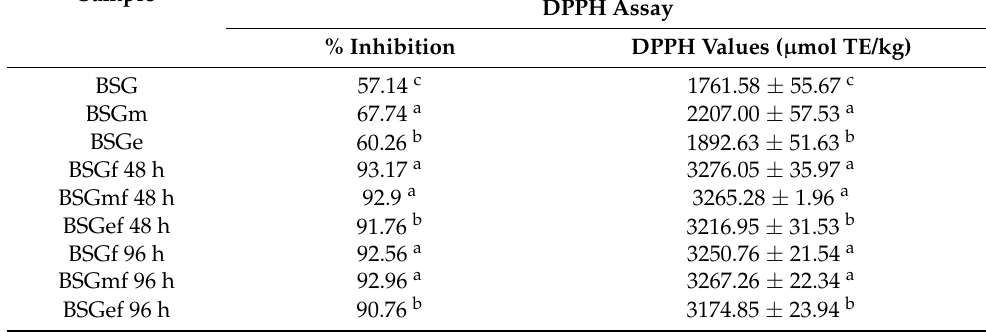
Table 4. Antioxidant capacity of free phenolic extracts from unfermented samples (brewers’ spent grain untreated (BSG), BSG milled (BSGm) and BSG extruded (BSGe)) and the fermented counterparts by Fusarium oxysporum after 48 h and 96 h 1 .